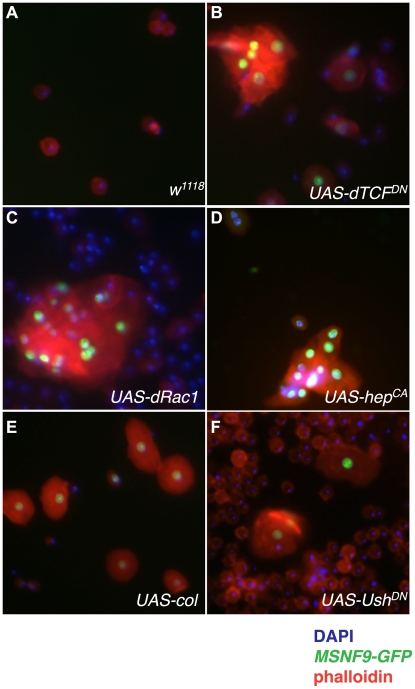

MSNF9-GFP expression in circulating hemocytes obtained from third-instar larvae of different genetic backgrounds that induce lamellocyte production.
A. w1118; He-Gal4 control. B. He-Gal4>UAS-dTCFDN. C. He-Gal4>UAS-dRAC1. D. He-Gal4>UAS-hepCA. E. Cg-Gal4>UAS-col. F. Cg-Gal4>UshDN. Hemolymph samples were also stained for DNA (DAPI) and filamentous actin (phalloidin).